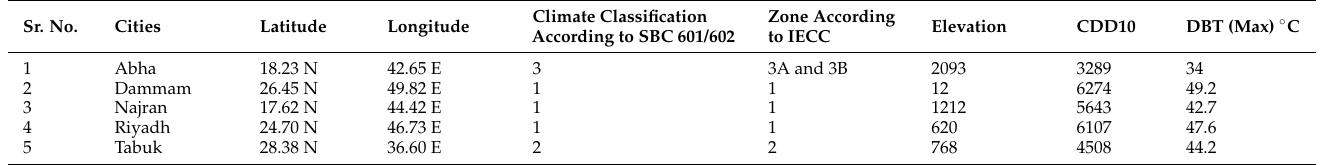
Table 3. Climate data of selected cities of Saudi Arabia.